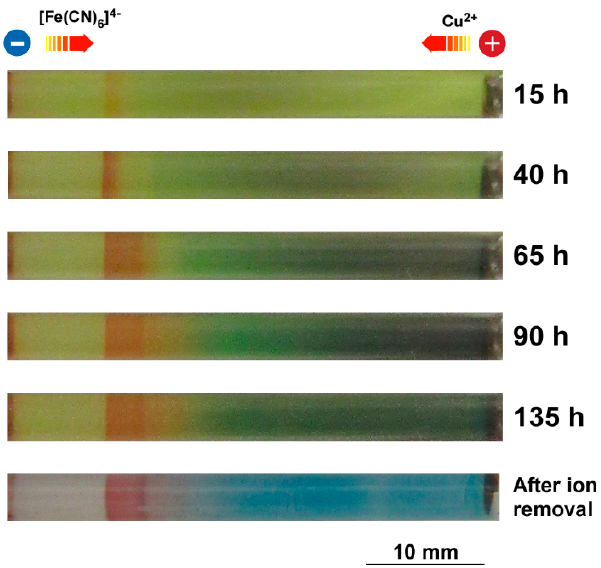
Figure 4. Spatiotemporal evolution of a multicolored pattern formed at 25 °C in the sample tube using the proposed RDR setup under an applied constant voltage of 2 V. The initial conditions are as follows: [[Fe(CN) 6 ] 3 − ] = 0.050 M and 2.0 mass% agarose. The elapsed time after voltage application is indicated at the right of each image. Bottom image: the pattern after removing unreacted ions. A scale bar is provided at the bottom of the image. Top: illustration of the charges of the electrodes and the movement direction of reactant ions induced by the electric field.